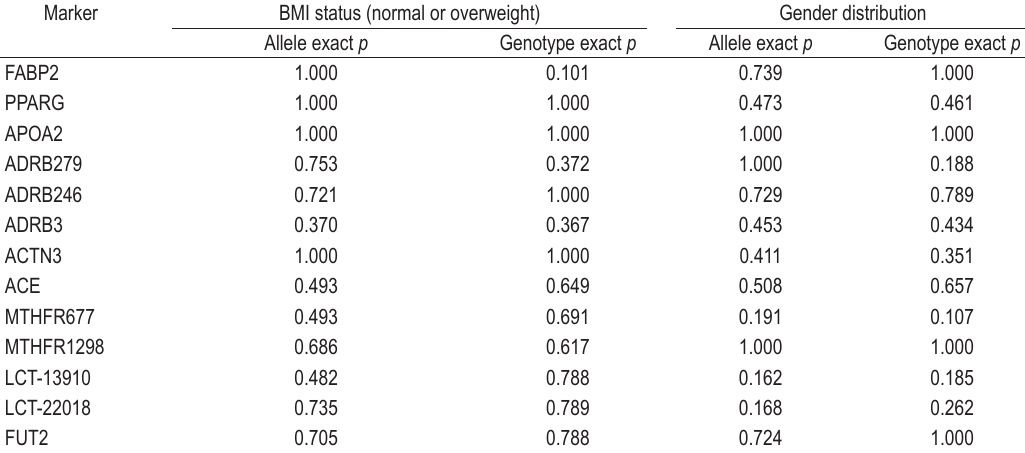
TABLE 4. Single‑locus case–control test results of the allelic and genotype association between the 13 observed gene polymorphisms, individual BMI status, and gender